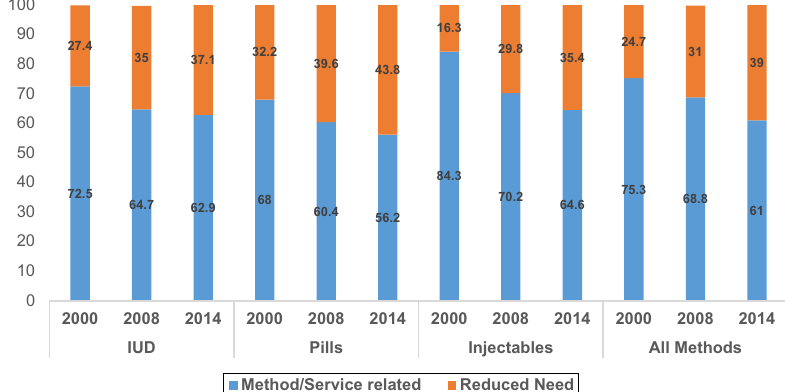
Figure 2. Percent